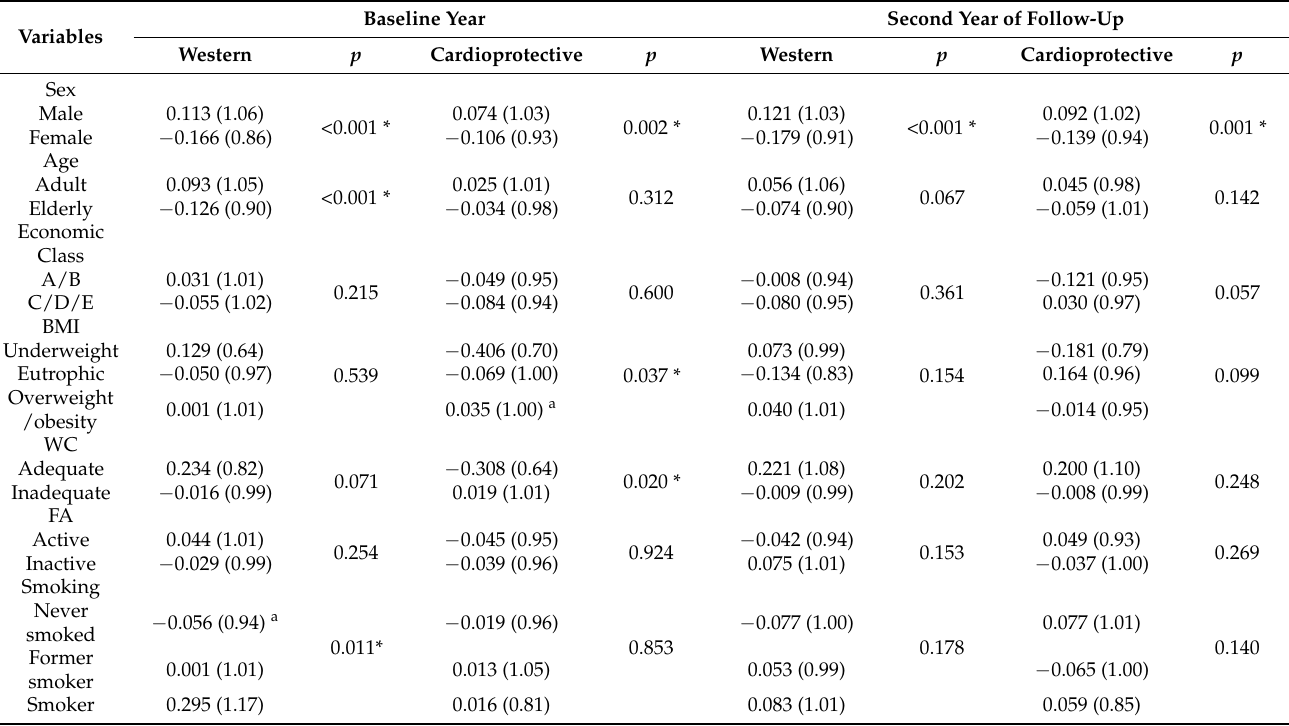
Table 5. Food patterns of the intervention group according to socioeconomic, nutritional status and lifestyle characteristics in the base year and in the second year of follow-up of the BALANCE program.